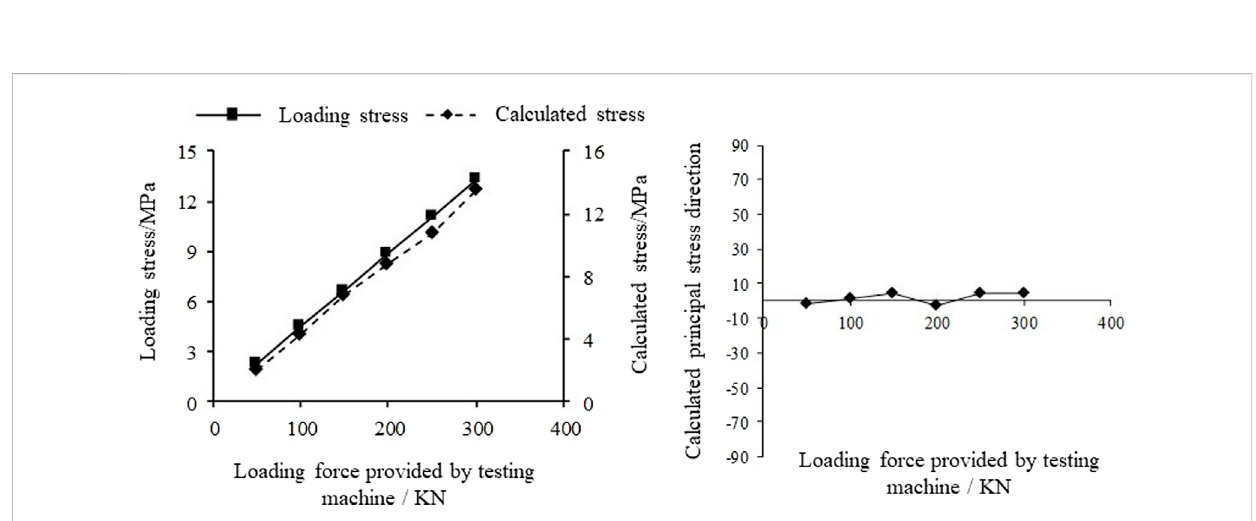
Frontiers in Earth